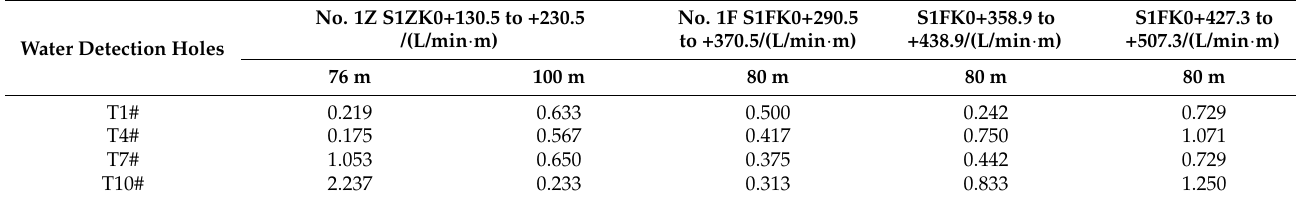
Table 24. Water output from different excavation sections.